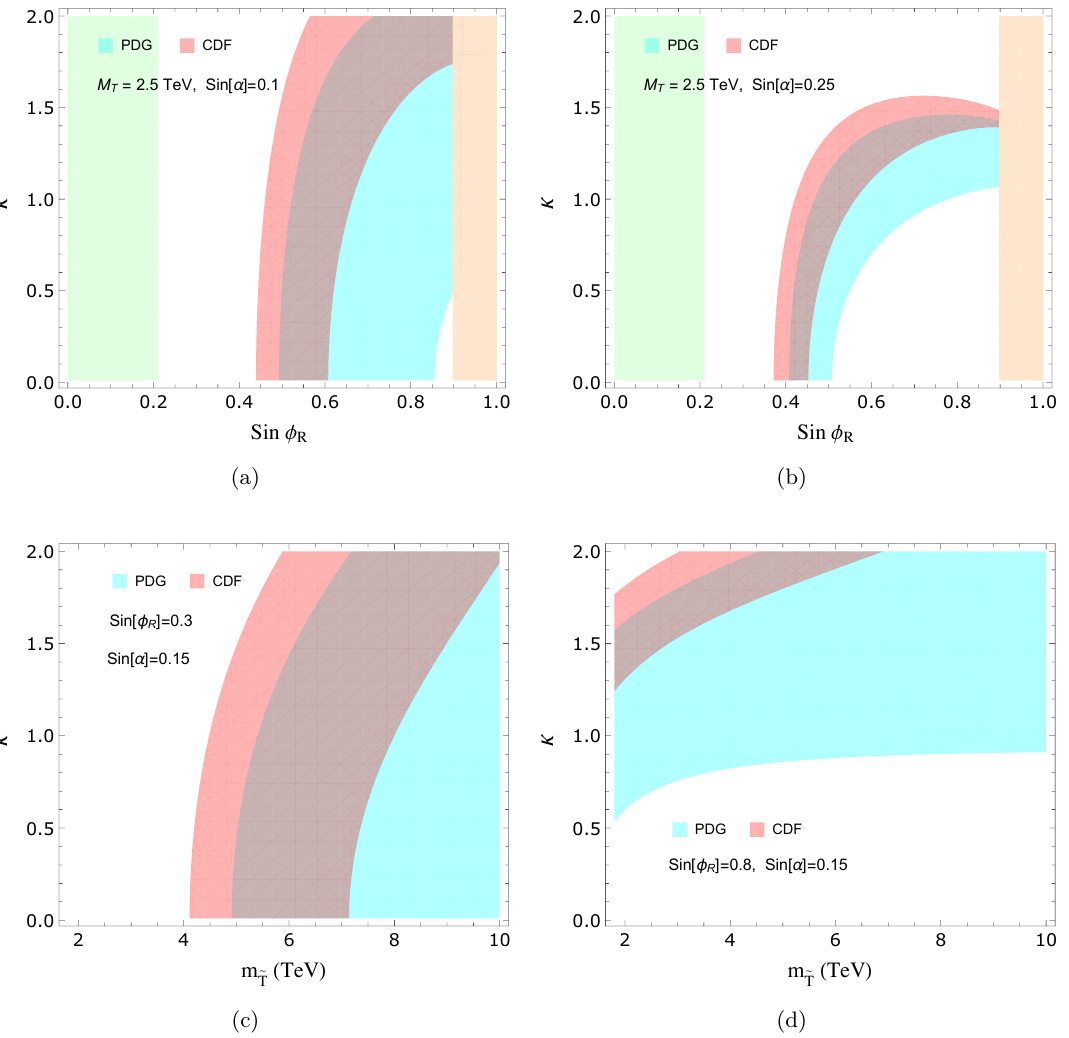
Figure 1 . The regions satisfied the precision measurements at 99% C.L. for the singlet scenario with ∆ M = 0 . 1 TeV. The red band is in light of CDF measurement of W mass and the cyan region is from the PDG global fit. In the upper panel, the green band with sin 2 φ R < 6 m t our perturbation analysis breaks down, and the yellow band is inferred from a lower bound of m T > 1 . 0 TeV 1